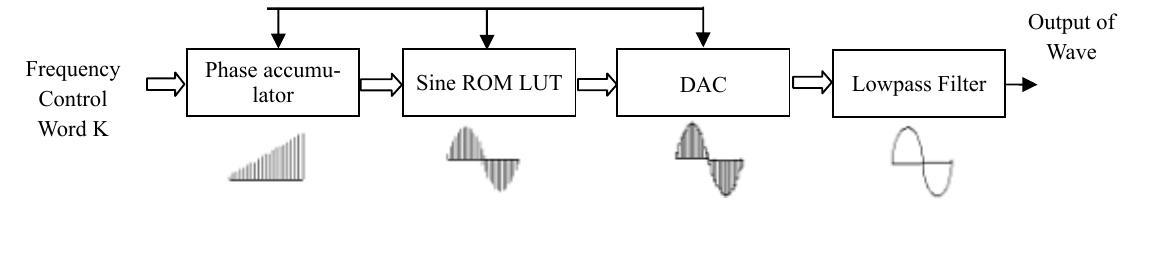
Fig. 1 Structural configuration of Basic DDS